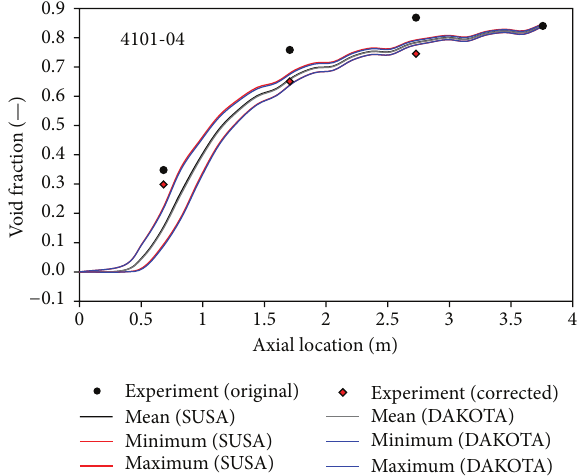
Figure 6: Axial void fraction profile for case 4101-04.